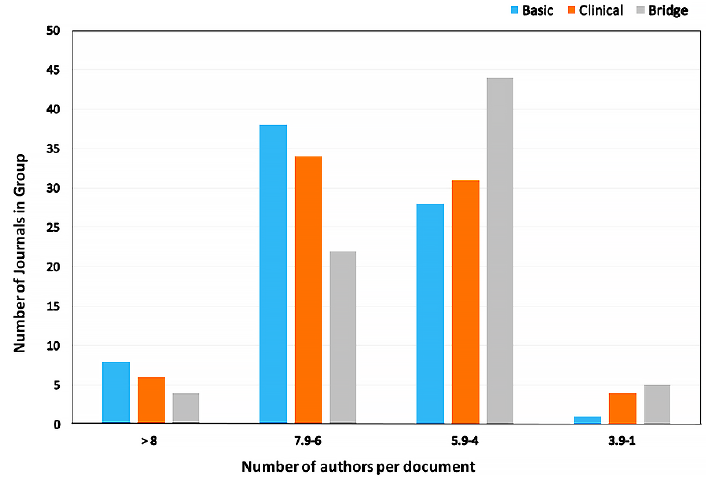
Figure 2. Distribution of co ‐ authors across the three categories.